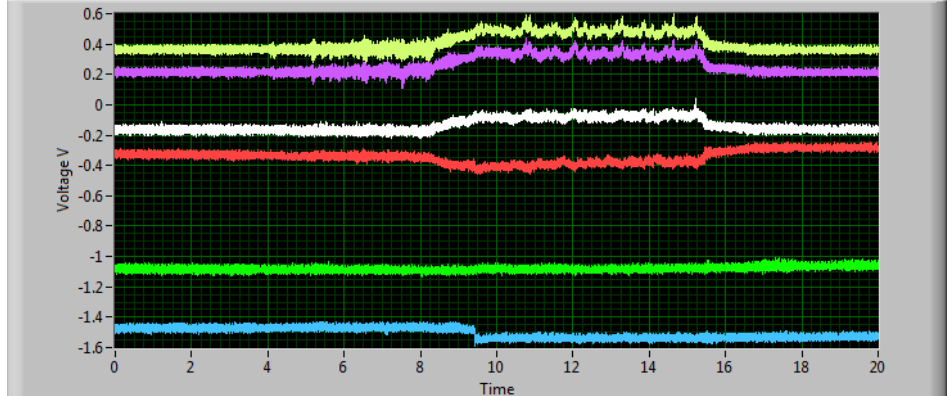
Figure 6. Electric signals measured by force sensor during cutting process of CK 44. Signal lines: yellow (1st from the top)–one part of the z axis, magenta (2nd from the top)–second part of the z axis, white (3rd from the top)–x + axis, red (4th from the top)–x − axis, green (5th from the top)–y + axis, blue (the bottom line)–y − axis.